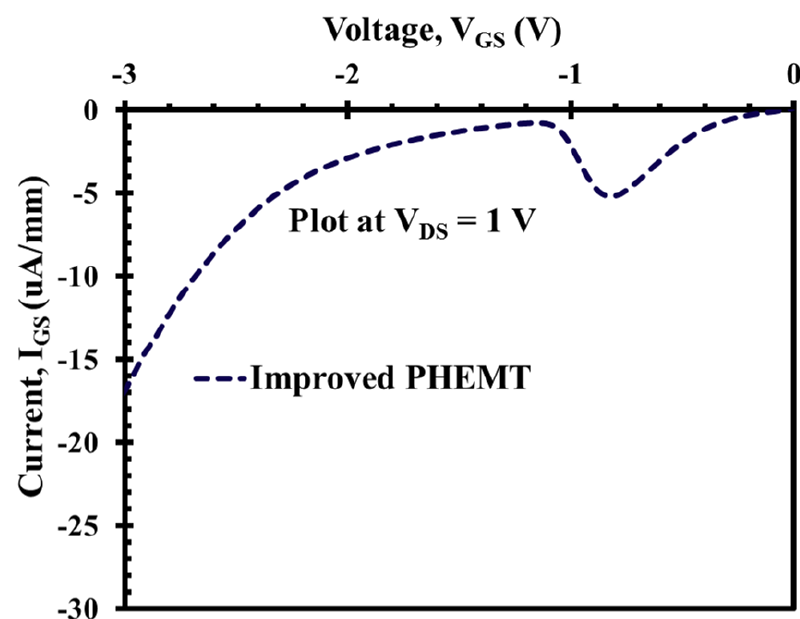
Figure 12. XMBE56 (improved pHEMT) on-state Schottky gate leakage current, in µ